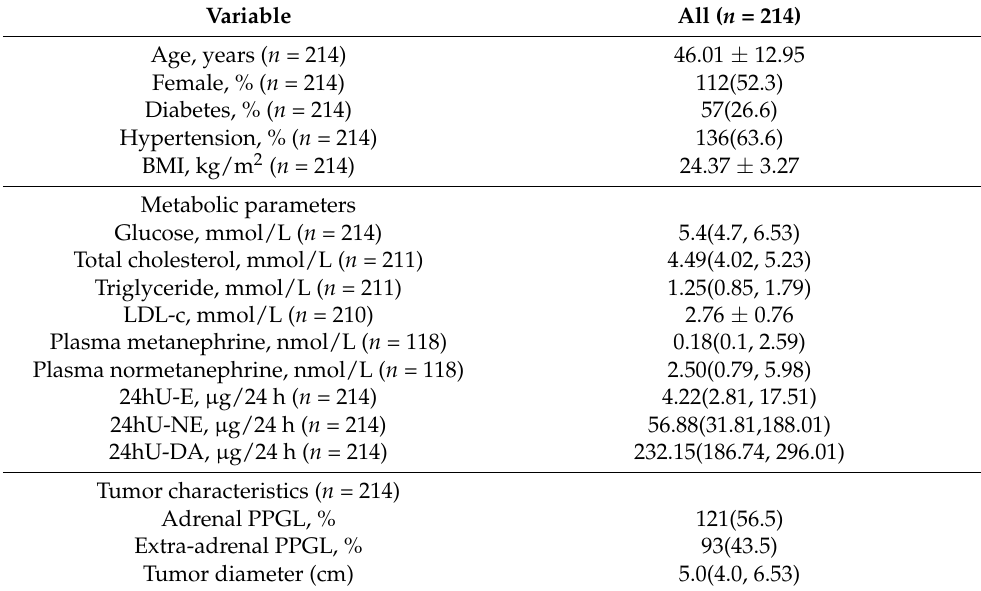
Table 1. Clinical characteristics of patients with pheochromocytoma and